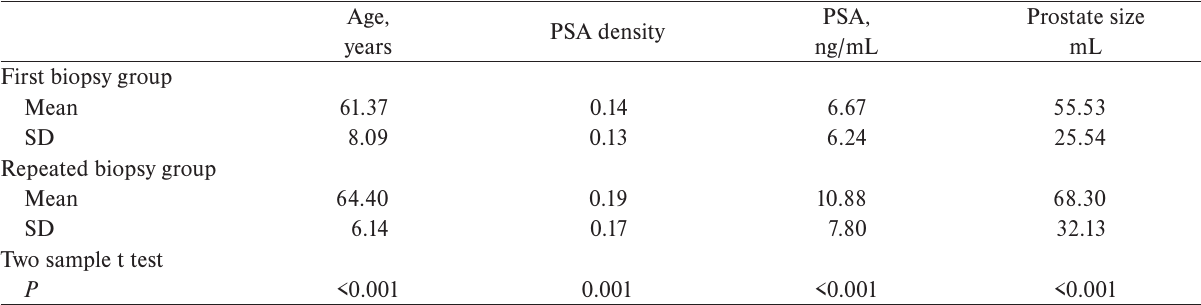
Table 1. Age, PSA, and prostate size in the first and repeated biopsy groups.